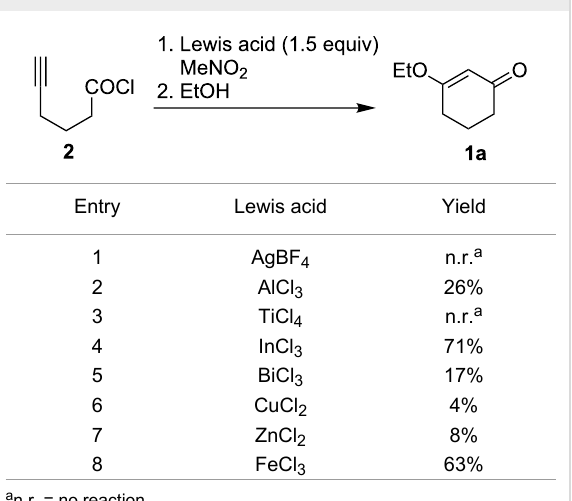
Table 1: Cyclization of 5-hexynoyl chloride to 3-ethoxy-2-cyclo- hexenone under Lewis acid conditions.